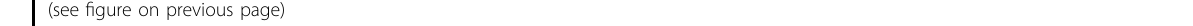
Fig. 1 Overview of T cell receptor signaling cascades. ADAP adhesion and degranulation-promoting adapter protein, BCL B cell lymphoma, Cbl casitas B-lineage lymphoma, CaM calmodulin, CaMKIV calcium/calmodulin-dependent protein kinase type IV, CARMA1 caspase recruitment domain- containing membrane-associated guanylate kinase protein 1, Cdc42 cell division control protein 42, CRAC calcium release-activated calcium, CRBN cereblon, CREB cAMP response element-binding protein, CTLA-4 cytotoxic T lymphocyte-associated protein-4, DAG diacylglycerol, DEPTOR DEP domain-containing mTOR-interacting protein, Dlgh1 discs large homolog 1, ERK extracellular signal-related kinase, F-actin fi lamentous actin, GADD45 α growth arrest and DNA damage inducible alpha, G β L G protein beta subunit-like, GRB2 growth factor receptor-bound protein 2, HPK1 hematopoietic progenitor kinase 1, IKK I κ B kinase, IP 3 inositol triphosphate, IP 3 R IP 3 receptor, JNK c-Jun N-terminal kinase, LAT linker for activation of T cells, Lck lymphocyte-speci fi c protein tyrosine kinase, LFA-1 lymphocyte function-associated antigen-1, MALT1 mucosa-associated lymphoid tissue lymphoma translocation protein 1, MAPK mitogen-activated protein kinase, MEK MAPK/ERK kinase, MEKK MAP kinase kinase kinase, MKK MAP kinase kinase, mTOR mammalian target of rapamycin, NCK noncatalytic region of tyrosine kinase adaptor protein 1, NF- κ B nuclear factor- κ B, NFAT